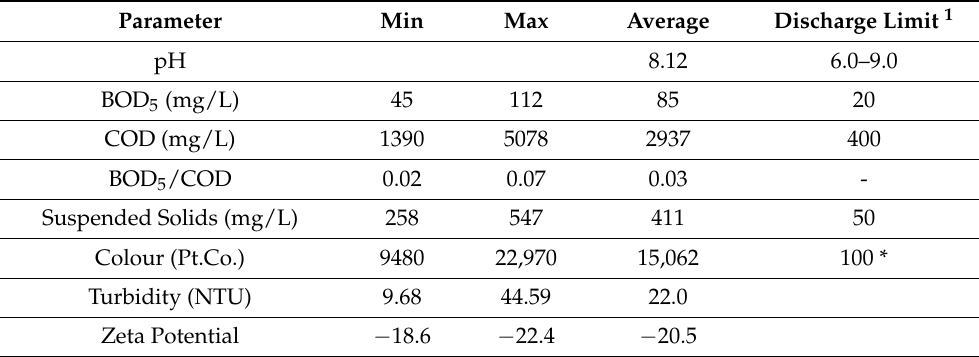
Table 1. Raw characteristics of APLS landfill leachate (based on 12 data, sampled between November 2018 until October 2019).